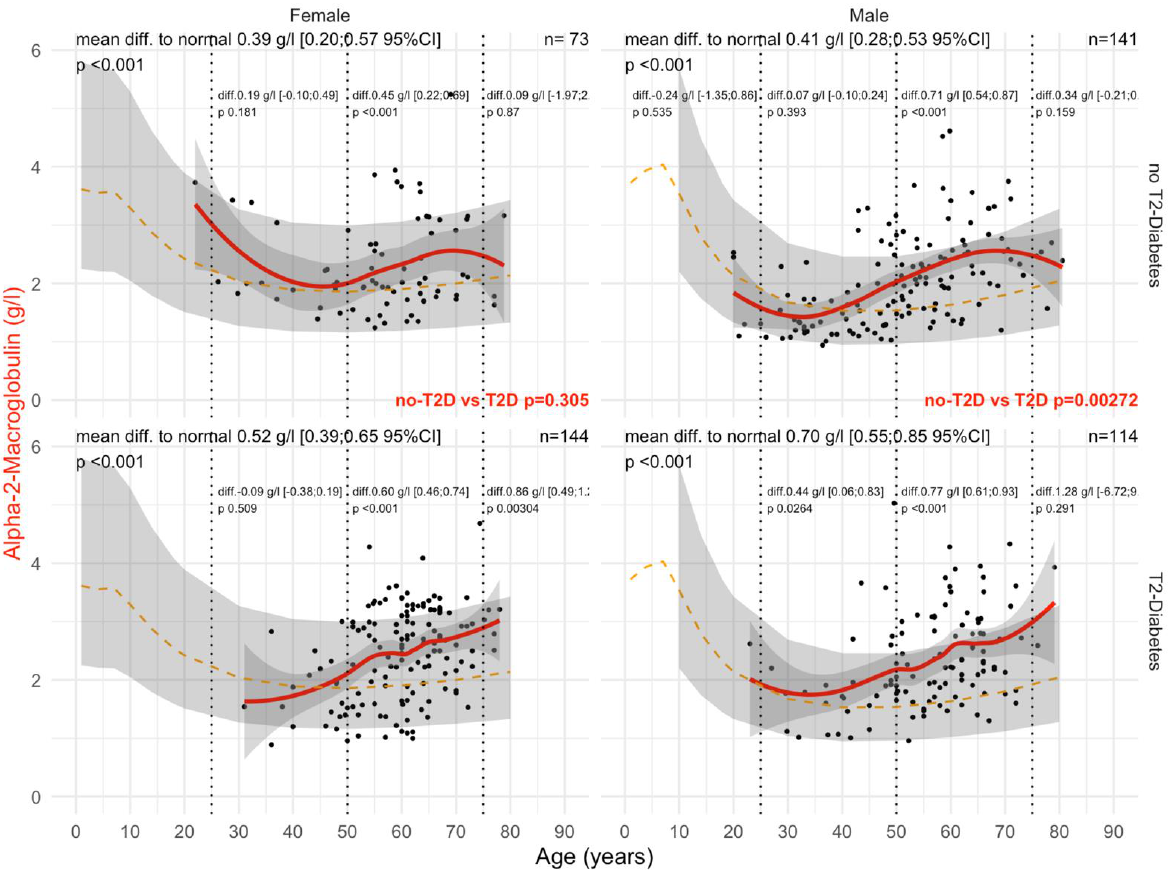
Figure 3. A2M levels in “NAFLD-Biopsy” patients with significant fibrosis stages F2F3F4. Impact of T2DM on A2M concentration in NAFLD-biopsied patients with clinically significant fibrosis F2F3F4 (n = 472). Normal serum means values according to age and sex (dashed–orange lines), with 95% confidence intervals (light-gray ribbon). Three vertical–dotted lines mark the four age groups (before 25, between 25 and 50, between 50 and 75, and above 75 years old). Each point is a patient’s protein value. The red curve is a Loess regression of the median A2M values, along with its 95% confidence interval (darker gray). For each age group, the mean difference (%95CI) between the patient protein value and the expected normal value (for age and sex) with its significance p -value is displayed at the top of the figure. The significance between the non-T2DM and T2DM patients is displayed in red between the 2 panels.